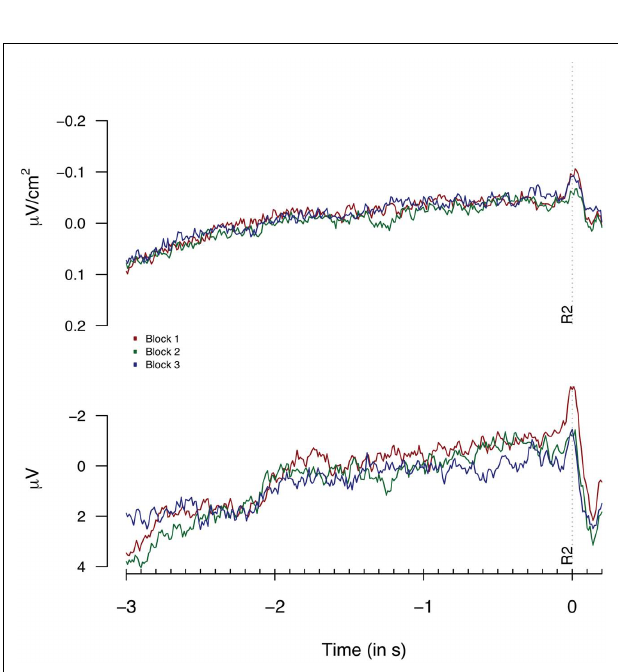
FIGURE 7 | Second response (R2) locked Laplacians (top graph, eight “3-in-a-row” participants) and monopolar recordings (bottom graph, all participants) obtained at FCz during Experiment 2 plotted separately for the first, second, and third 33% of all